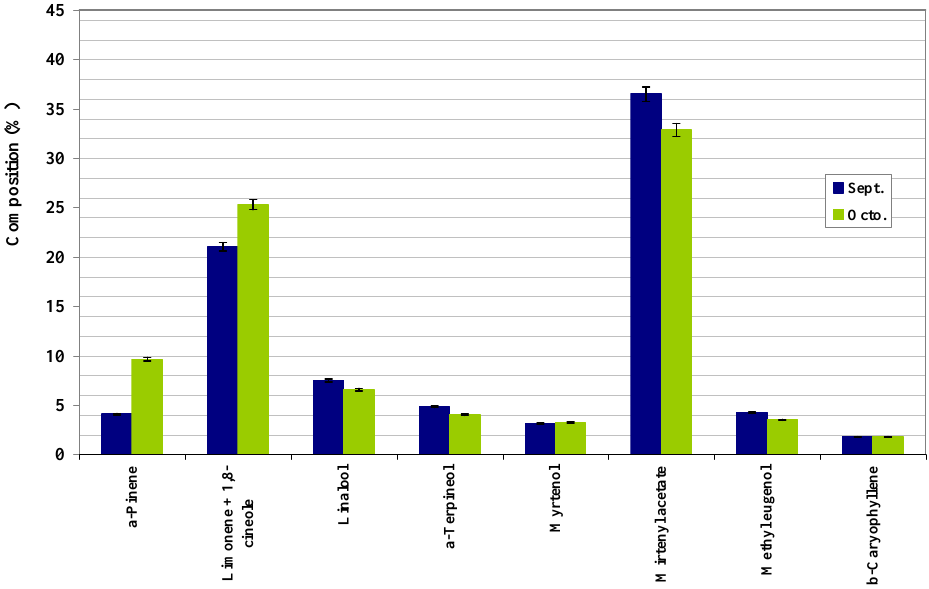
Figure 3 . Composition of main compounds of berries essential oil of Portuguese